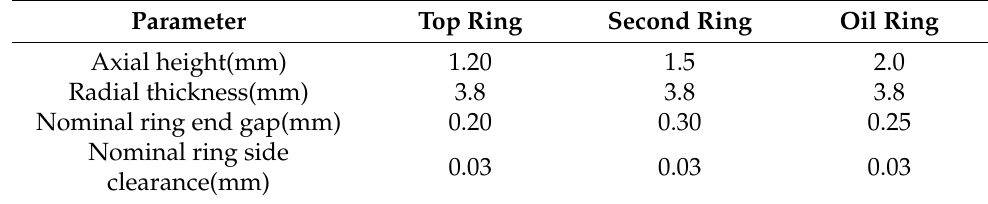
Table 2. Main dimensions of the piston